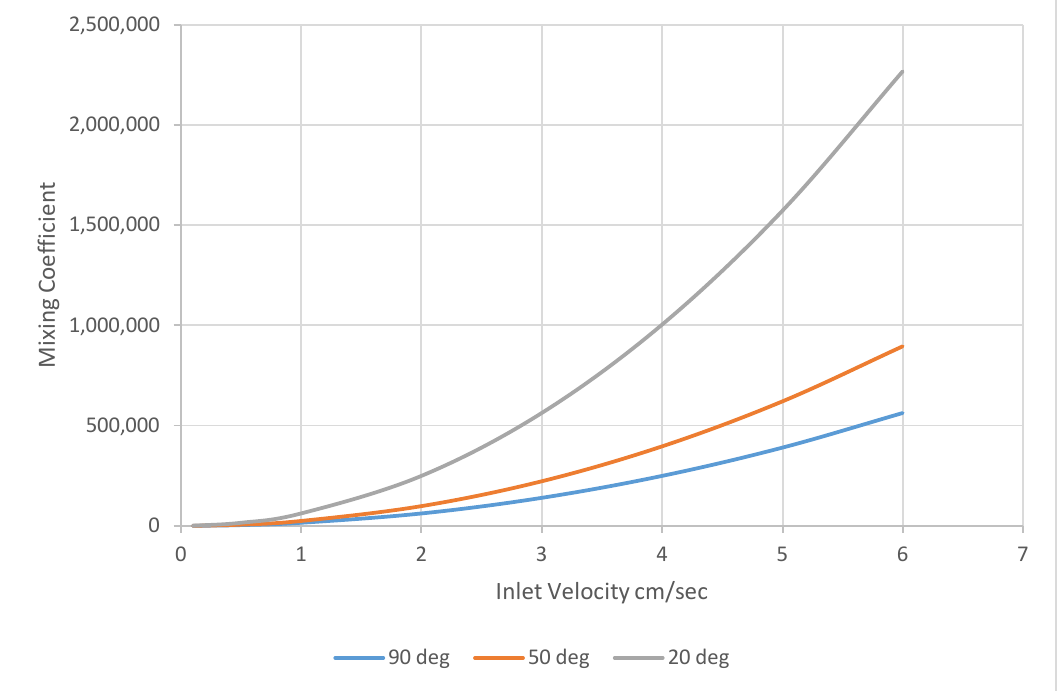
Figure 3. Graph showing the mixing effect for different tank water temperatures and inlet velocities (inlet water temperature is 10 °C).